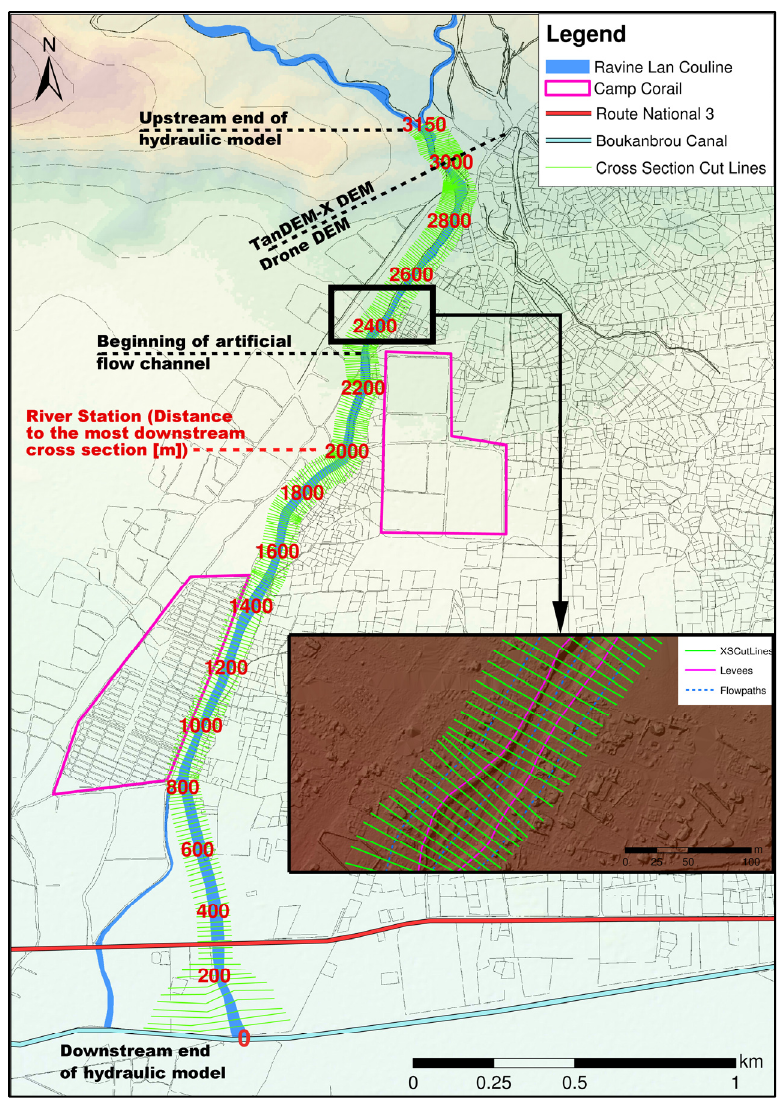
Figure 14. Geometric model configuration and development in